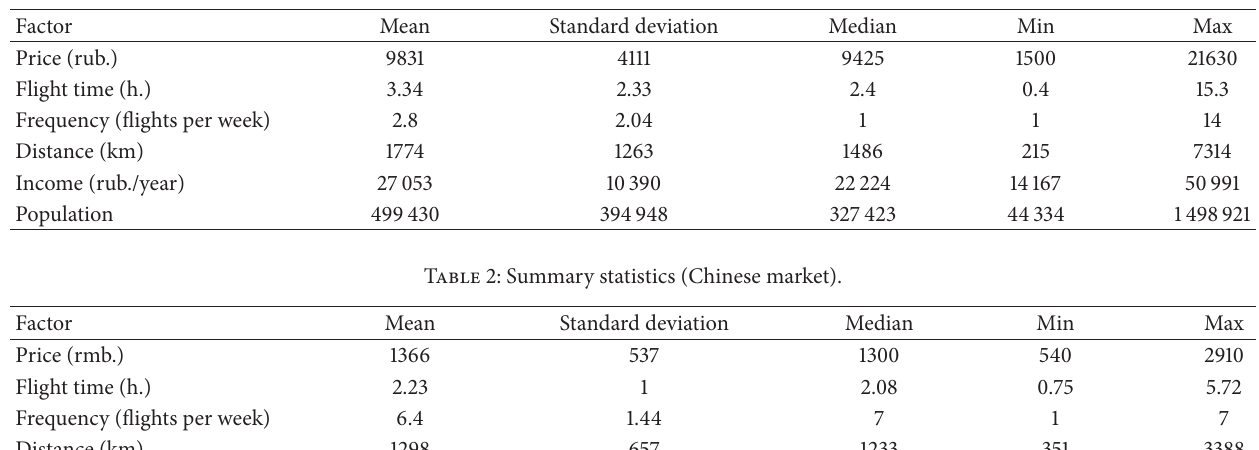
Table 1: Summary statistics (Russian market).